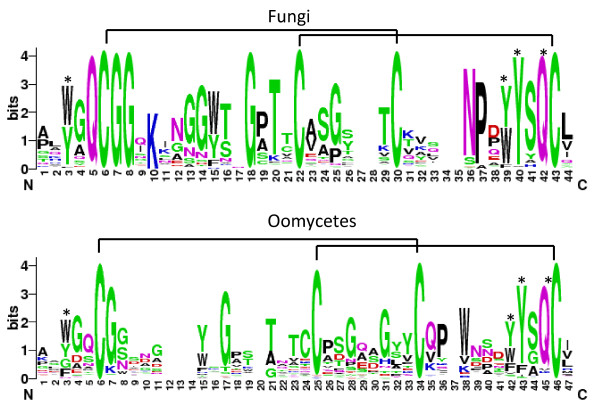
Weblogos built from fungal and oomycetal CBM1 sequences. The height of the residues represents their conservation among the peptide sequences. Cysteine residues engaged in disulphide bonds are materialized as black lines. The glutamine and aromatic residues that are known in fungi to be important for interaction with crystalline cellulose are shown by asterisks. Similarly these residues susceptible in oomycetes to interact with the carbohydrate substrate are depicted with asterisks.